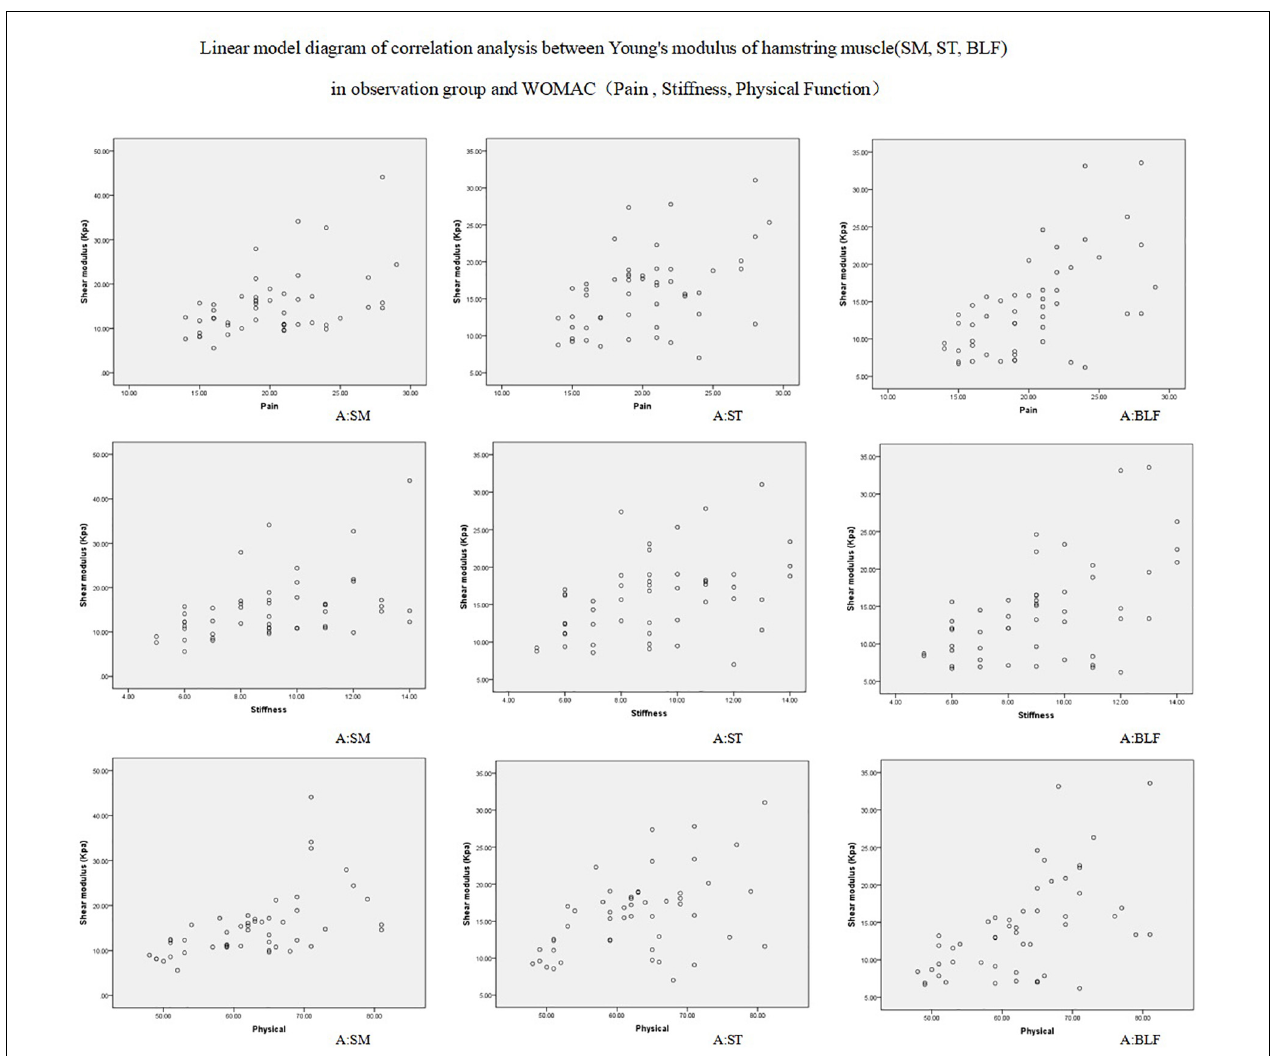
FIGURE 2 | Correlation between the three hamstring shear modulus and WOMAC score in the observation group.